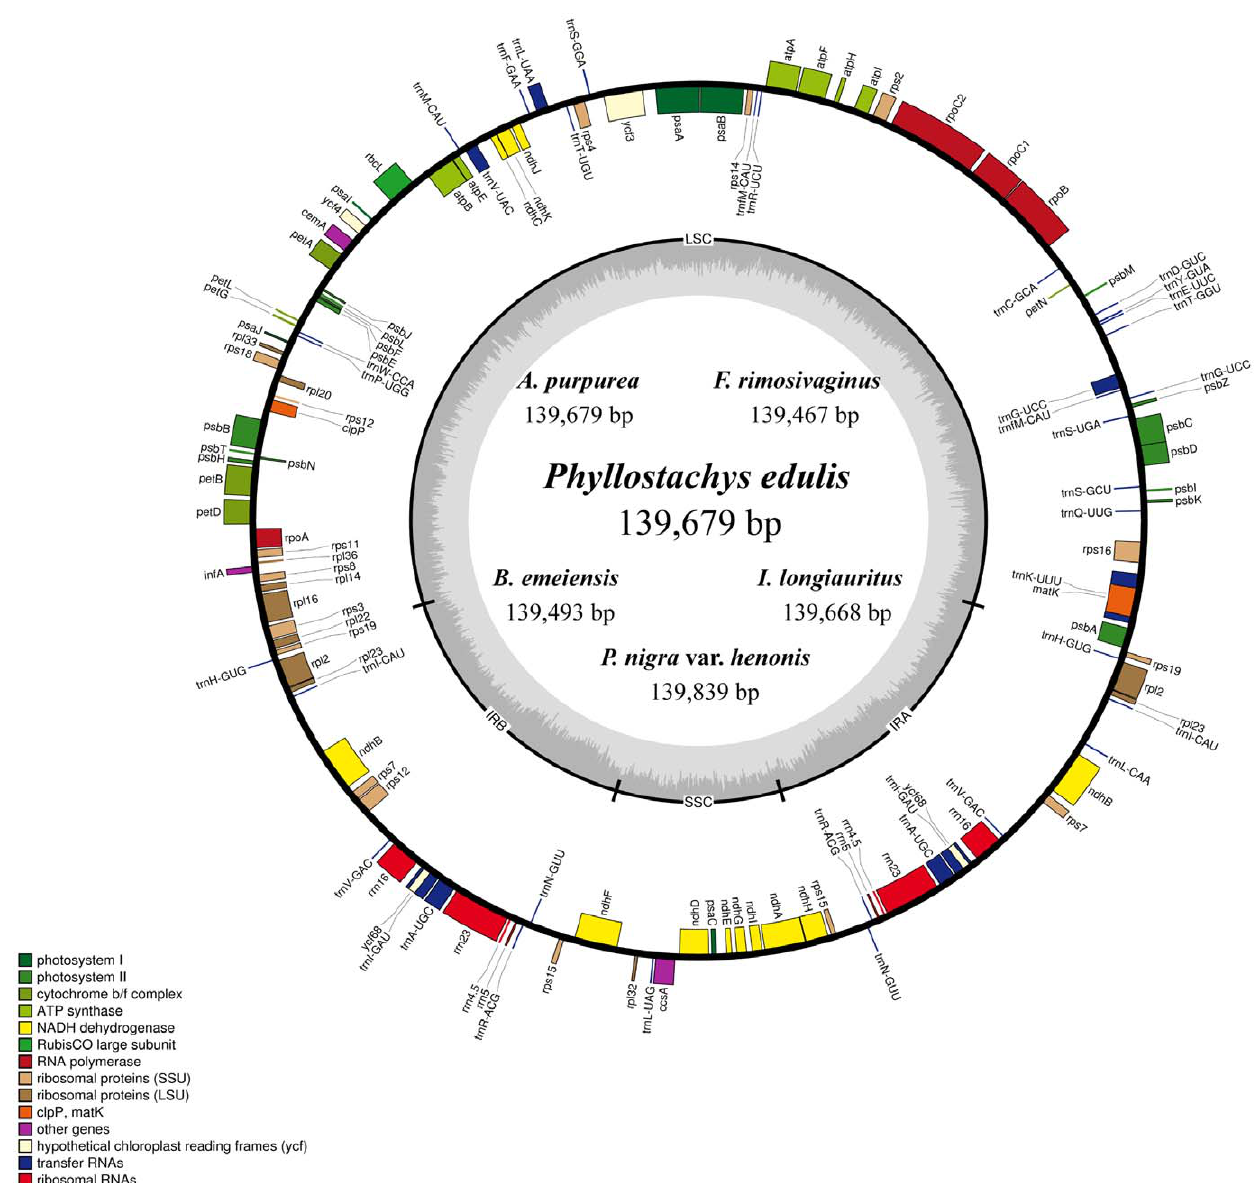
Figure 1. Gene map of the six woody bamboo chloroplast genomes. Genes shown outside the outer circle are transcribed clockwise and those inside are transcribed counterclockwise. Genes belonging to different functional groups are color coded. Dashed area in the inner circle indicates the GC content of the chloroplast genome.